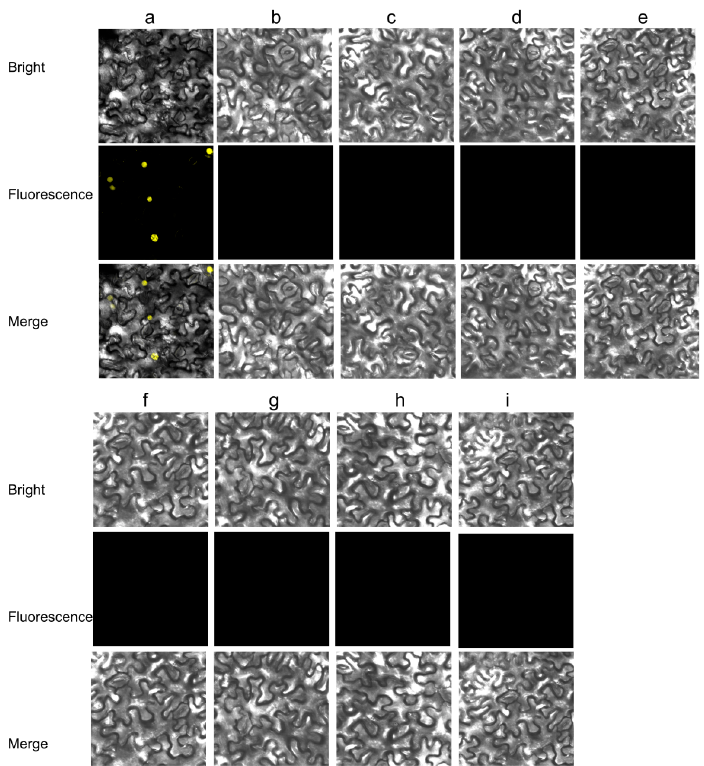
Figure 8. BIFC assays to confirm the interactions of CpCZF1 and CpCZF2. ( a ) the construct pair CpCZF1-nEYFP and CpCZF2-cEYFP was used to detect the protein interaction in tobacco cells. The construct pairs; ( b – i ) were used as negative controls; ( b ) CpCZF1-nEYFP and AtSZF1-cEYFP ; ( d ) nEYFP-CpCZF1 and AtSZF1-cEYFP ; ( f ) CpCZF1-cEYFP and AtSZF1-nEYFP ; ( c ) CpCZF1-nEYFP and cEYFP-AtSZF1 ; ( e ) nEYFP-CpCZF1 and cEYFP-AtSZF1 ; ( g ) CpCZF1-cEYFP and nEYFP-AtSZF1 ; ( h ) cEYFP - CpCZF1 and AtSZF1-nEYFP ; ( i ) cEYFP - CpCZF1 and nEYFP-AtSZF1.